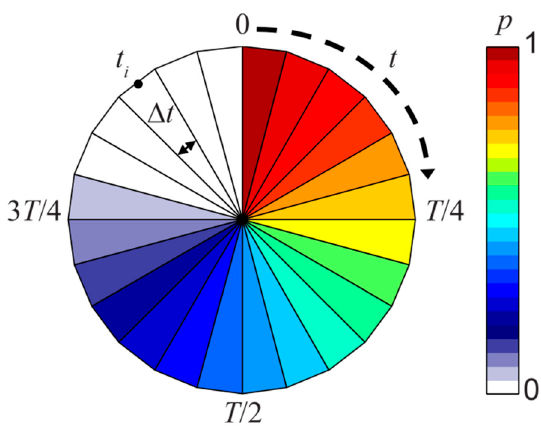
Figure 1. An example of a retention clock, adapted from 21. Time progresses clockwise from 0 to a preset maximum time T (in subsequent figures, T = 22 days) with a time step of t ( t = 2 days in all subsequent figures). Color scales represent the ratio of particles ( P ) initiated in the source polygon which are observed in a given destination polygon.